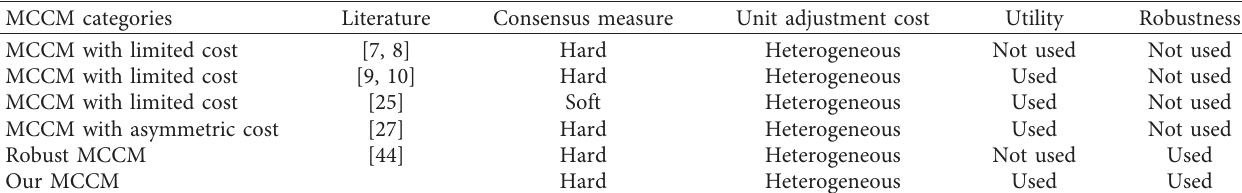
Table 9: MCCM studies with different designs of key